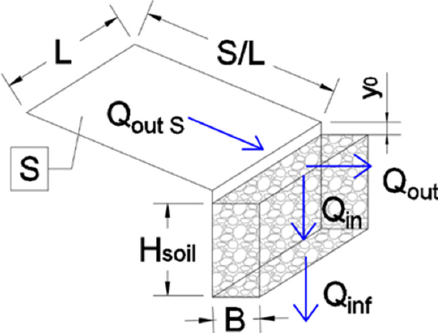
Figure 1. Schematic representation of the infiltration system.